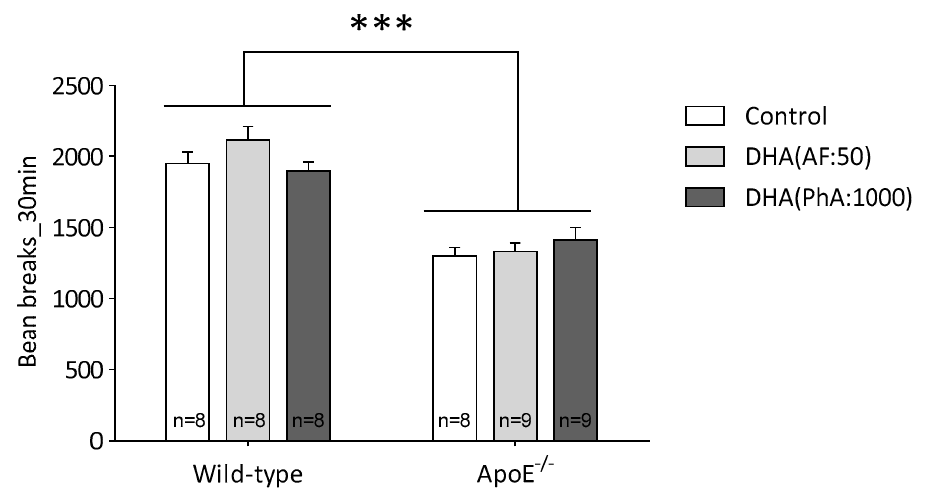
Figure 1. Effects of docosahexaenoic acid (DHA)(PhA:50) and DHA (PhA:1000) on spontaneous mouse locomotor activity in ApoE − / − and wild ‐ type mice. Data shown as mean ± SEM. *** p < 0.0001 compared between genotypes. ( n = 8 or 9).